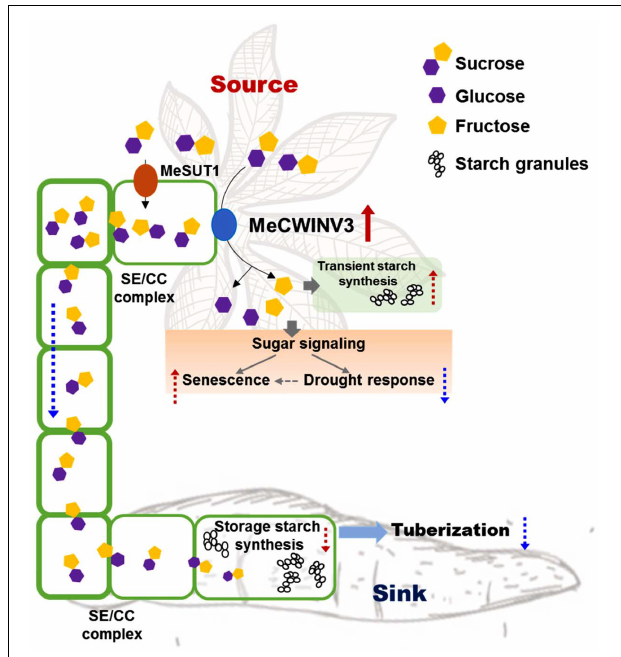
FIGURE 11 | Schematic illustration of MeCWINV3 function on sucrose hydrolysis to regulate the sugar allocation from source to sink in vascular bundles. Normally, the photo-assimilates (sugars) from source cells are transported to root parenchyma cells via phloem loading mainly in the form of sucrose molecules for the use of starch biosynthesis to support storage root tuberization. In leaves, overexpression of MeCWIN3 promotes the sucrose hydrolysis (red up arrow), leading to increased transient starch accumulation, accelerated leaf senescence, and reduced drought tolerance. In stems, the rate of sucrose transportation is reduced. As a result, starchy storage root tuberization is repressed. Red up dash arrow indicates increased activity and blue down dash arrow indicates reduced